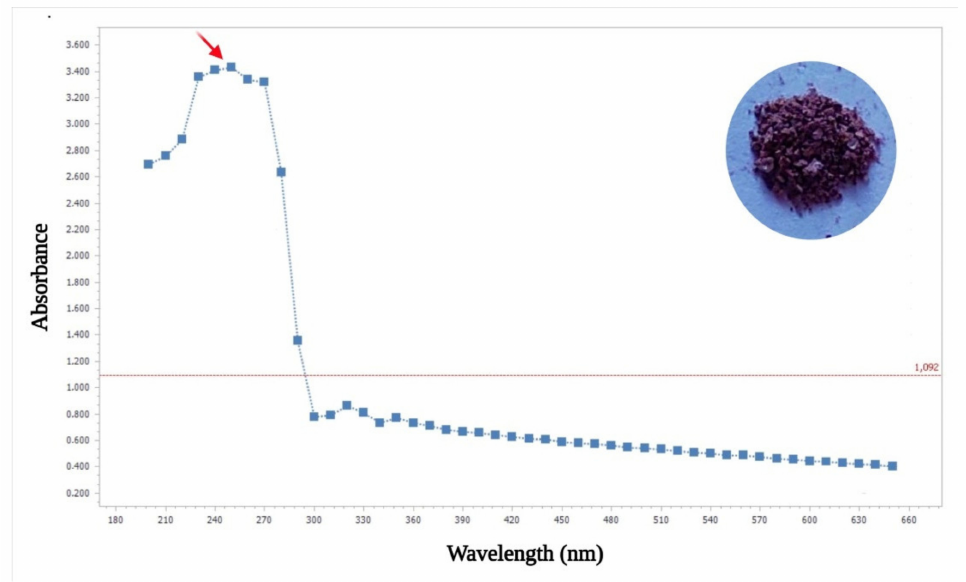
Figure 4. UV-Vis absorption spectrum (inset dry brown pigment compound) showing bacterial pyomelanin such as absorption with a peak at 250 nm (red arrow in the